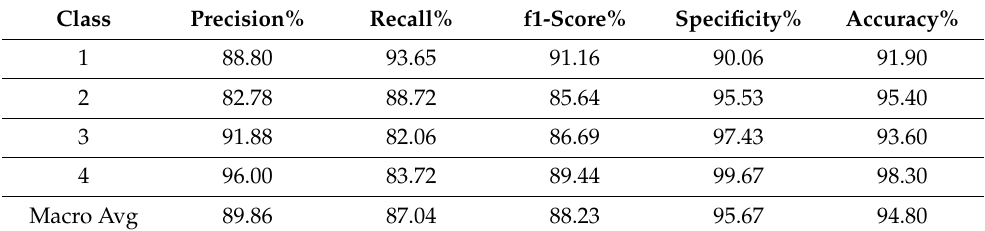
Table 2. Class -wise performance of the MESSIDOR dataset.